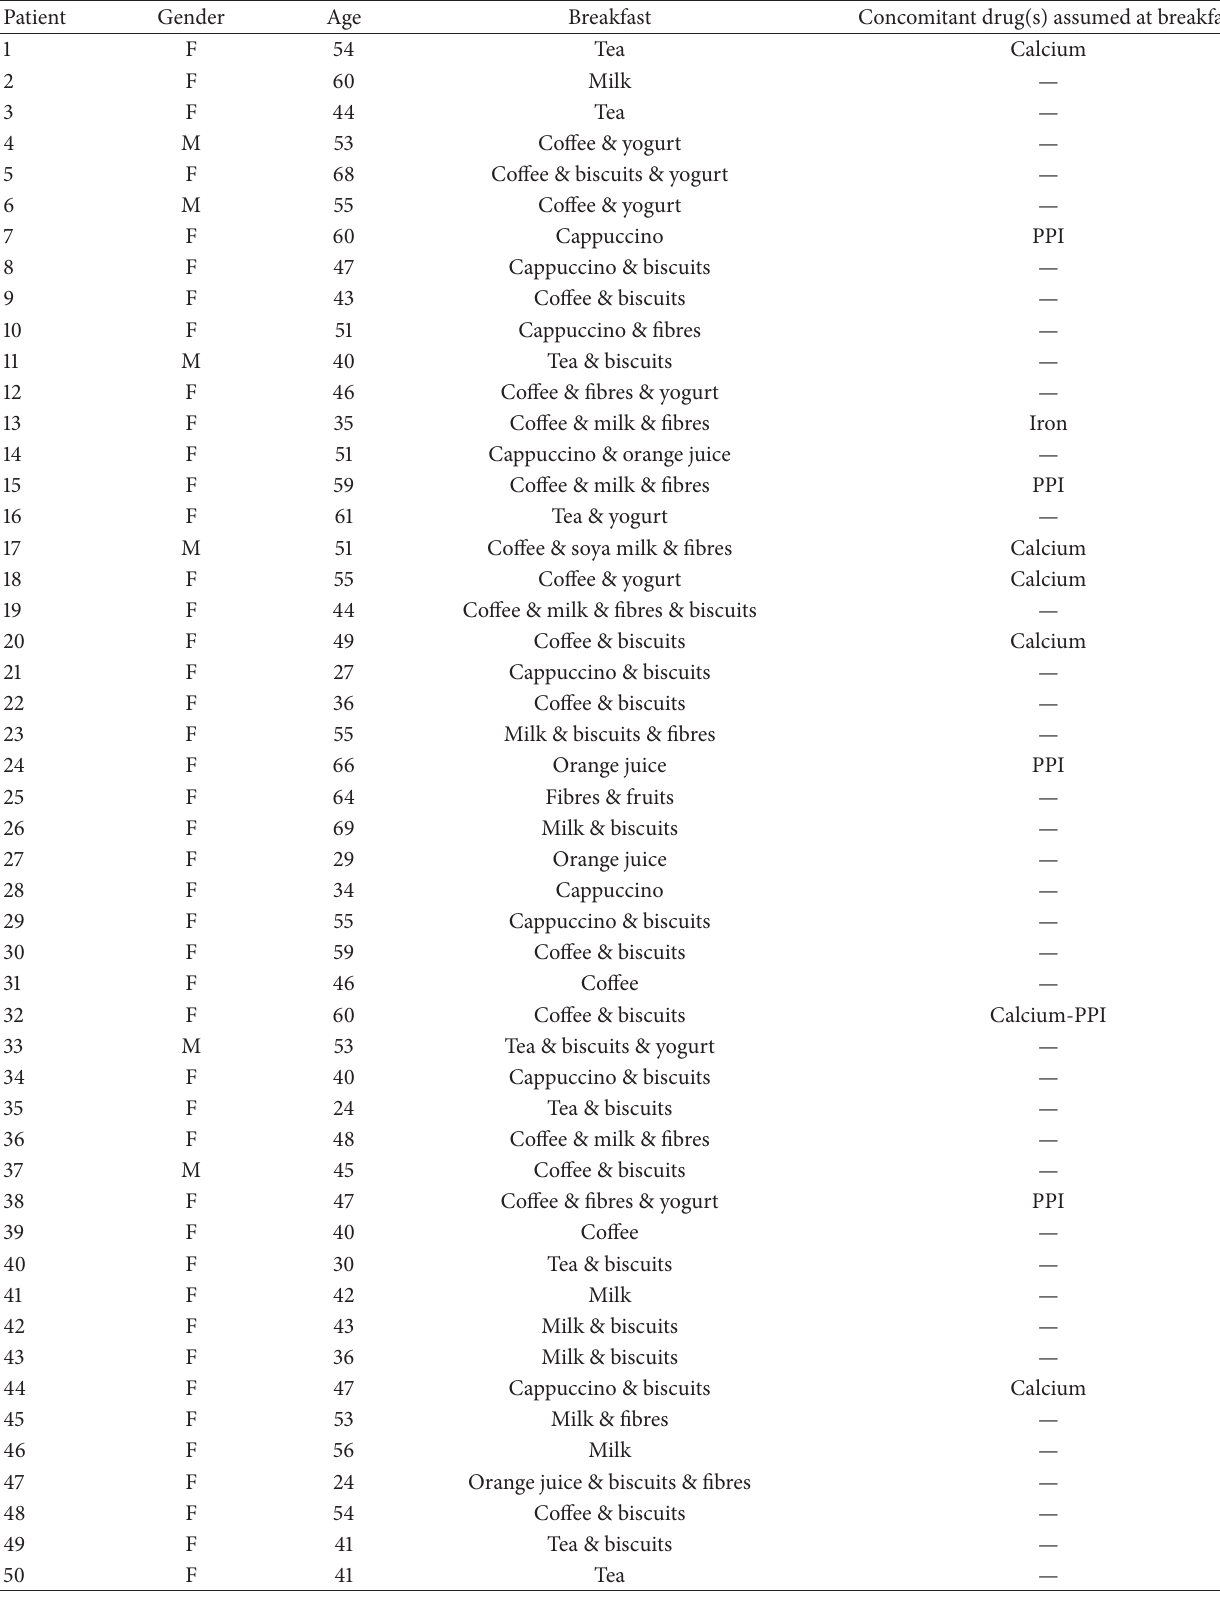
Table 1: Breakfast composition and concomitant drug treatment of the patients in the